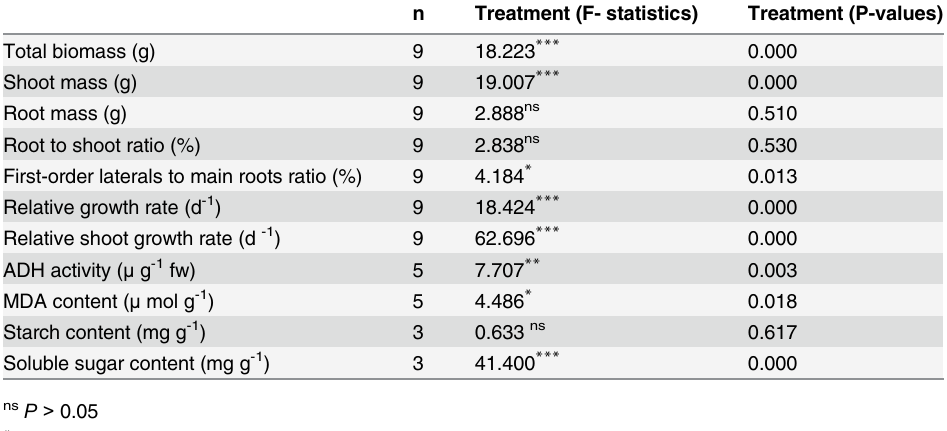
Table 1. Summary of one-way ANOVAs for total biomass, ADH activity, and carbohydrates contents of Carex schmidtii in different water-level